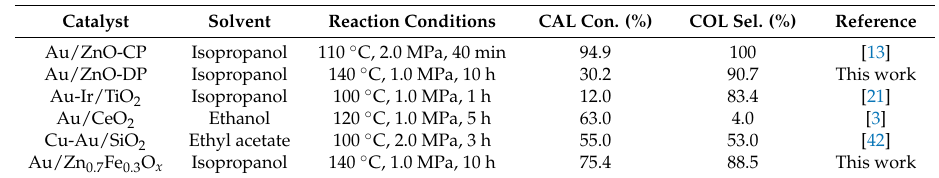
Table 7. Comparison of catalytic results for cinnamaldehyde hydrogenation over gold nanocatalysts in the literature and in this work.